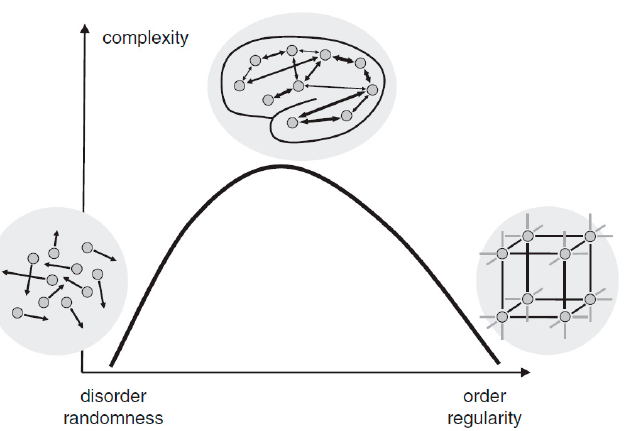
Figure 1. The relationship between randomness and complexity. Reprinted with permission from ref. [10]. Copyright 2015 John Wiley and